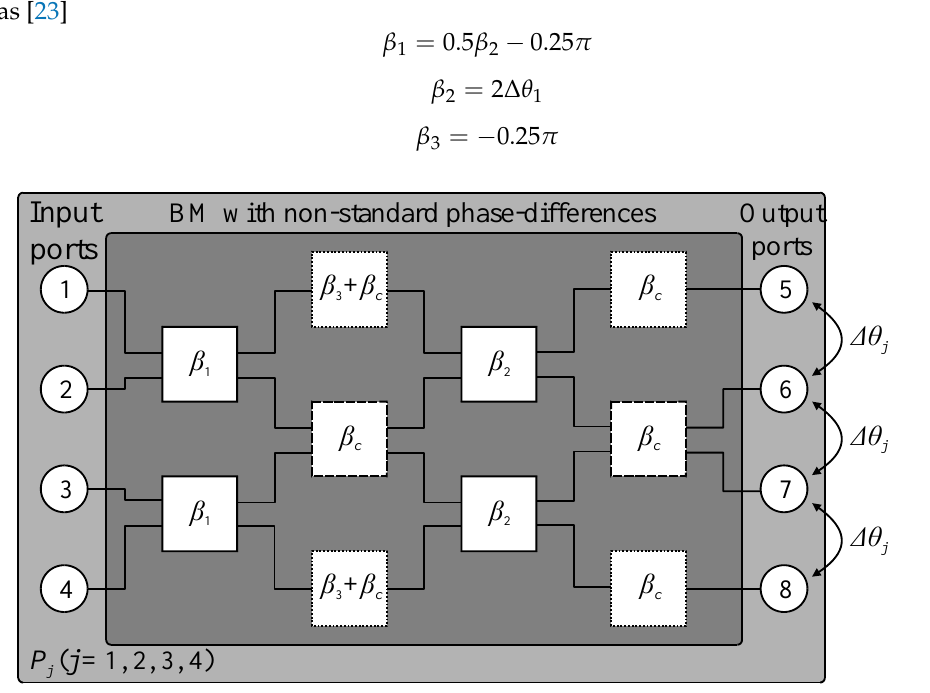
Figure 4. Butler matrix with nonstandard output-port phase differences: a conceptual illustration. Here, β 1 and β 2 represent phase shifts introduced by the first and second pair of BLCs, whereas β 3 is the electrical length of the phase shifter. As shown in Figures 4 and 5a, the component β c represents the electrical length of crossovers. Based on (4)–(6), one can infer that phase differences at output ports of the BM are a function of β 2 . Consequently, ∆ θ ∆ θ ∆ θ − 0.5 π , and ∆ θ 1 = 0.5 β 2 , 2 = 0.5 β 2 + π , 3 = 0.5 β 2 4 = 0.5 β 2 + 0.5 π [23]. The feasible ranges of phase shifts β 1 and β 2 —i.e., the ones for which realizable topologies of compact BLCs can be obtained—vary from − 30 ◦ to − 90 ◦ . Therefore, the attainable output-port phase differences are ∆ θ 1 ∈ [ − 45 ◦ ; − 15 ◦ ], ∆ θ 2 ∈ [135 ◦ ; 165 ◦ ], ∆ θ 3 ∈ [ − 135 ◦ ; − 105 ◦ ], and ∆ θ ∈ [45 ◦ ; 75 ◦ ], respectively. The parameters β 4 1–3 are used as the starting points for design of individual matrix